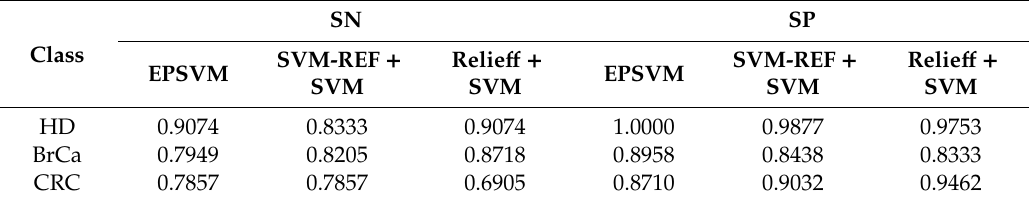
Table 8. SN and SP of dataset 14 for each class ( α = Table 7. SN and SP of dataset 10 for each class (  = 0.5).